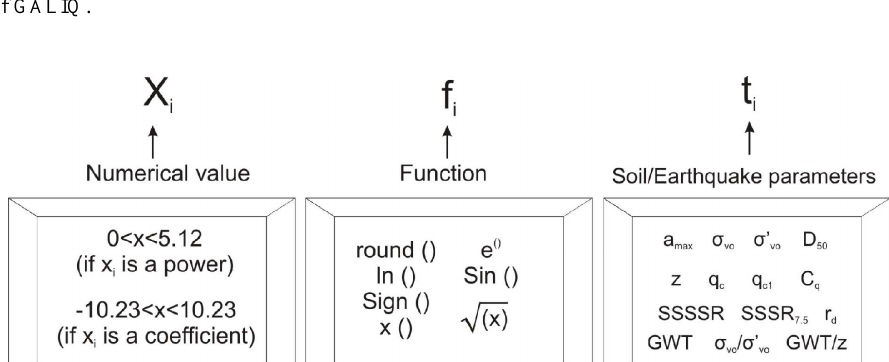
Fig. 2. Flow chart of GALIQ.